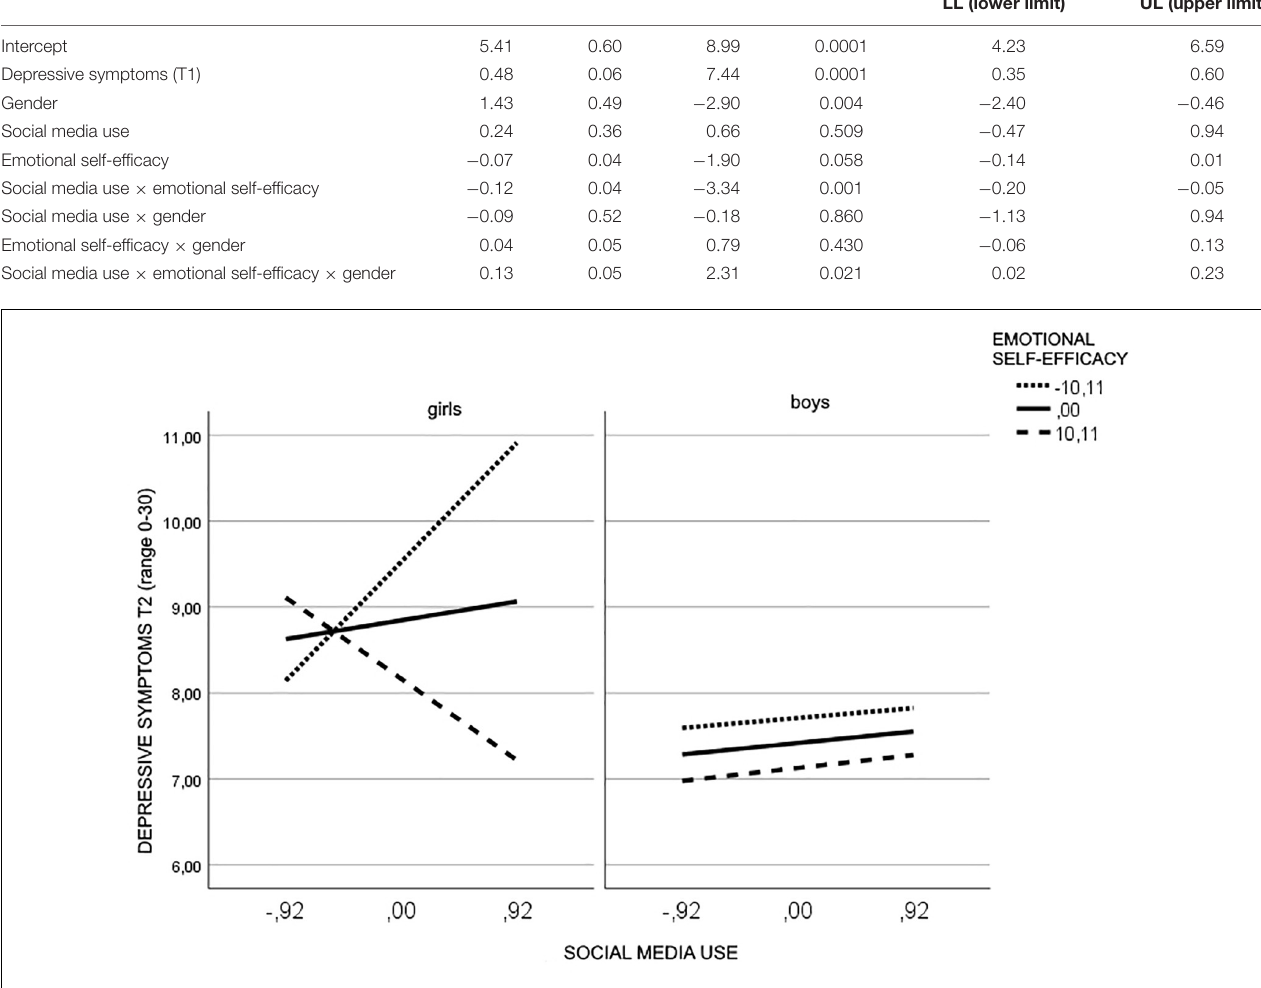
FIGURE 2 | Moderating effect of emotional self-efficacy and gender in the relationship between social media use and depressive